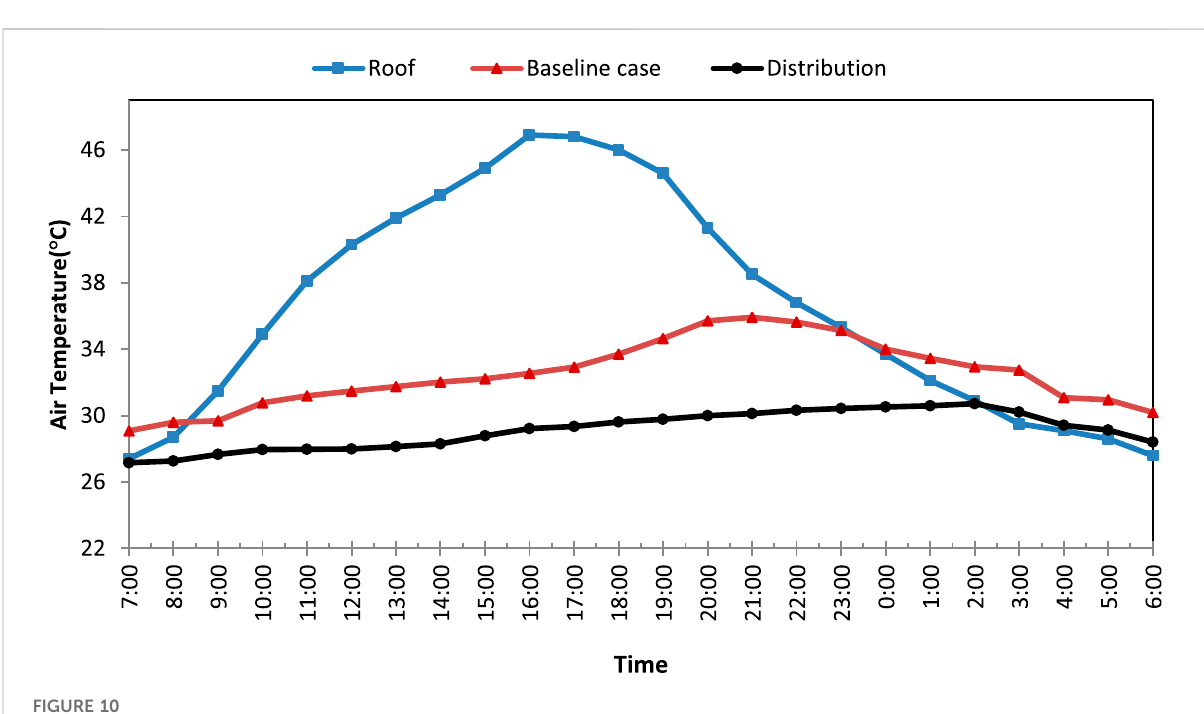
FIGURE 10 Temperature variation over 24 h with recycled glass insulation material distributed on the roof in